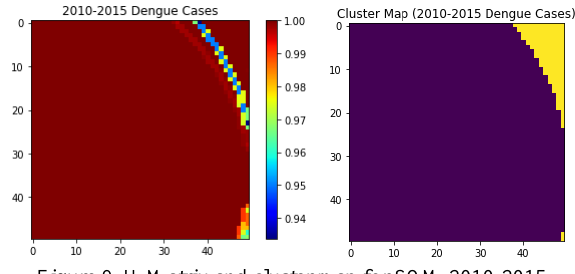
Figure 9. U-Matrix and cluster map for SOM 2010-2015. The clusters were then mapped to the geographic space. Figure 10 shows the clusters in Quezon City. Using the combined data from 2010 to 2015 appeared to have divided Quezon City into two clusters, the north and south areas. The north area (red polygon) has barangays with a relatively higher number of dengue cases. On the other side, the south area (blue polygon) has barangays with a relatively lower number of dengue cases. The comparison between the dengue cases between the two clusters can be seen in the time-series plot in Figure